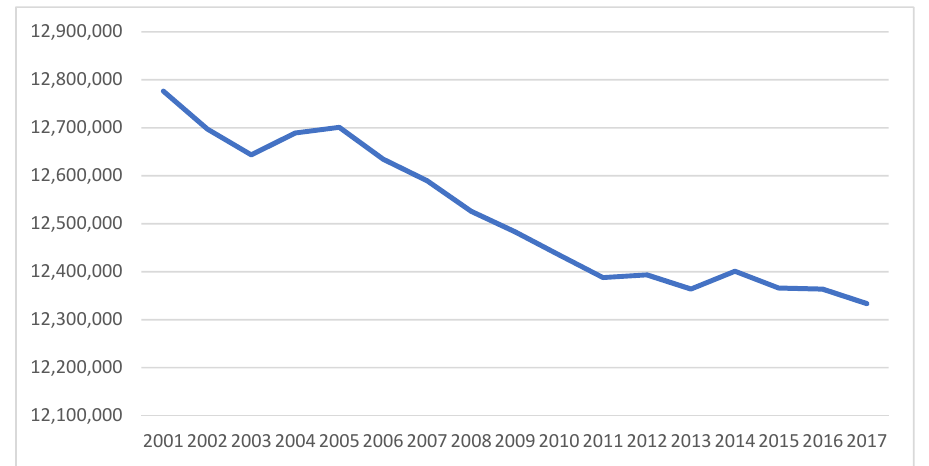
Figure 1. The total number of grazing permits and leases: animal unit months (AUMs) from 2001 to 2017. Source: BLM Public Land Statistics (BLM [46]).